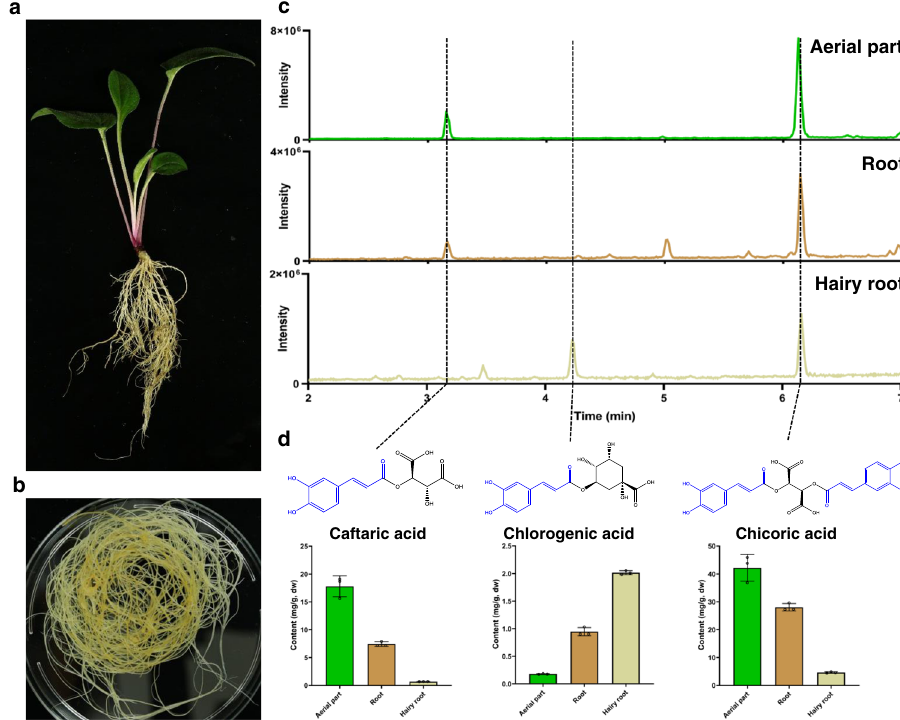
Fig. 1 Main caffeic acid derivatives in purple cone fl ower. a Two-month-old seedlings and b hairy root cultures of purple cone fl ower. c Total ion chromatograms (TIC) of aerial parts, roots, and hairy root cultures. d Main caffeic acid derivatives (CADs) and their abundance. Data are mean±s.d. ( n = 3 biologically independent samples). Source data underlying Fig. 1d are provided as a Source Data fi